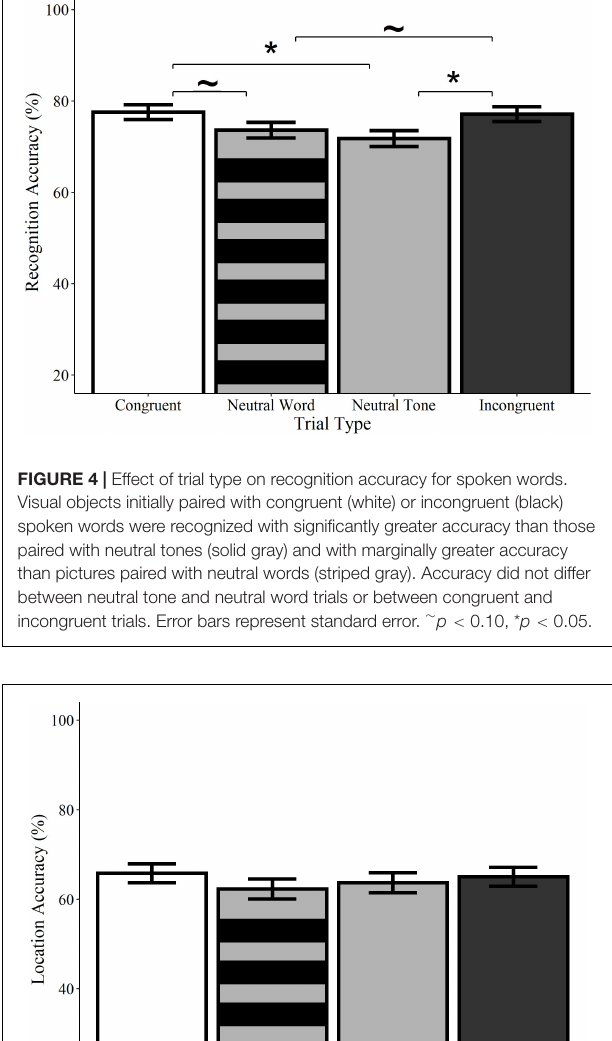
presentation of congruent or incongruent words relative